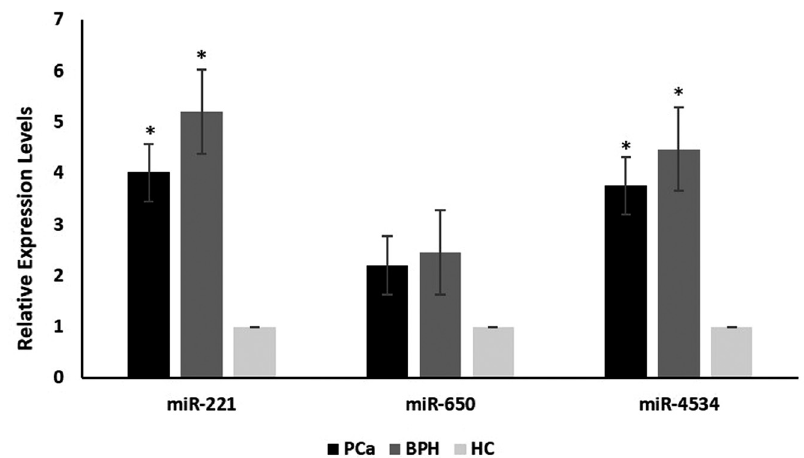
Figure 2: Relative miRNA expressions of PCa and BPH compared to